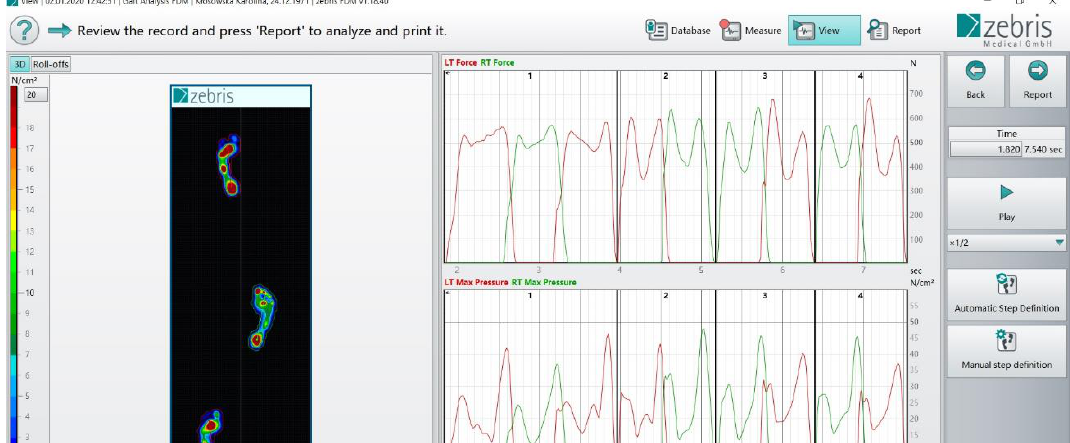
Figure 1. The gait parameters at a Zebris pedobarographic platform.